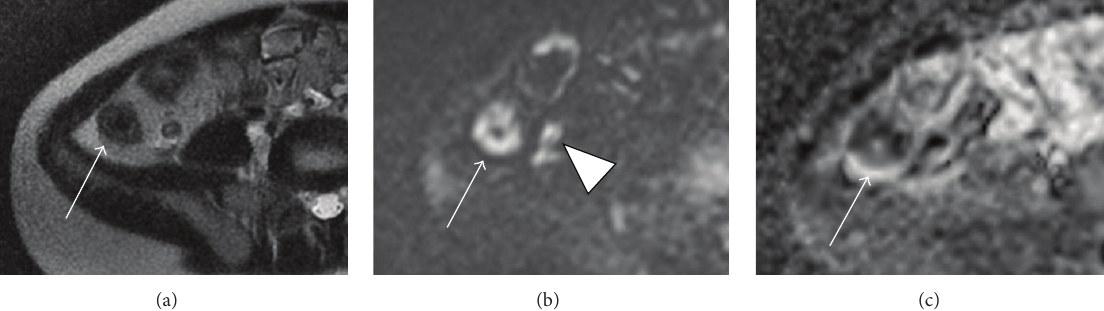
Figure 3: Diffusion-weighted imaging of active Crohn’s disease. (a) Axial single-shot T2-weighted image demonstrating wall thickening and edema in the terminal ileum; (b) DWI and (c) ADC images (𝑏 = 600) demonstrating hyperintense signal on DWI and low ADC (arrow) in the same region of the terminal ileum indicating restriction of diffusion. There is also restricted diffusion in the distal ileum and appendix (arrowheads) consistent with additional areas of